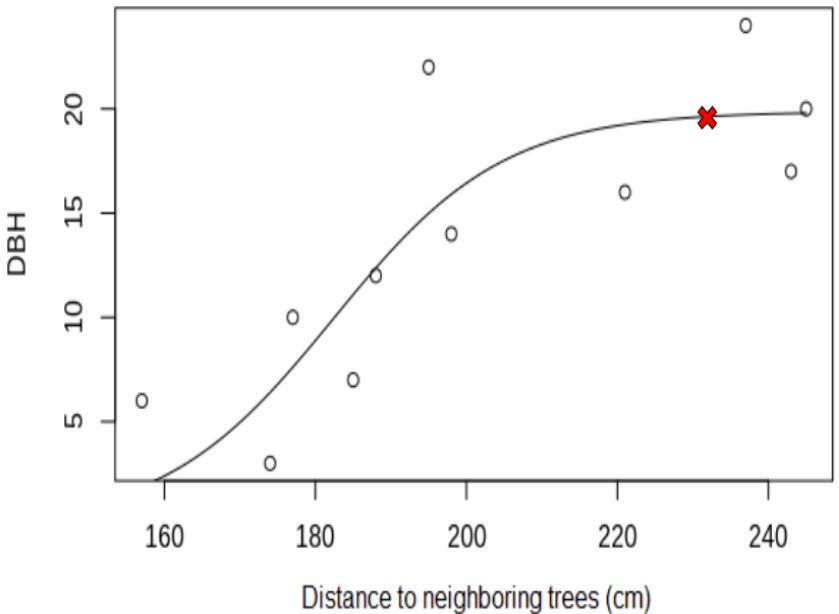
Figure 8. Dependence of the DBH on the average distance to neighboring trees. The line was fitted using a Logistic (or Gompertz) nonlinear relationship that allows for estimation of the asymptote of 2.3 m (lower 95% bound, upper 95% bound).